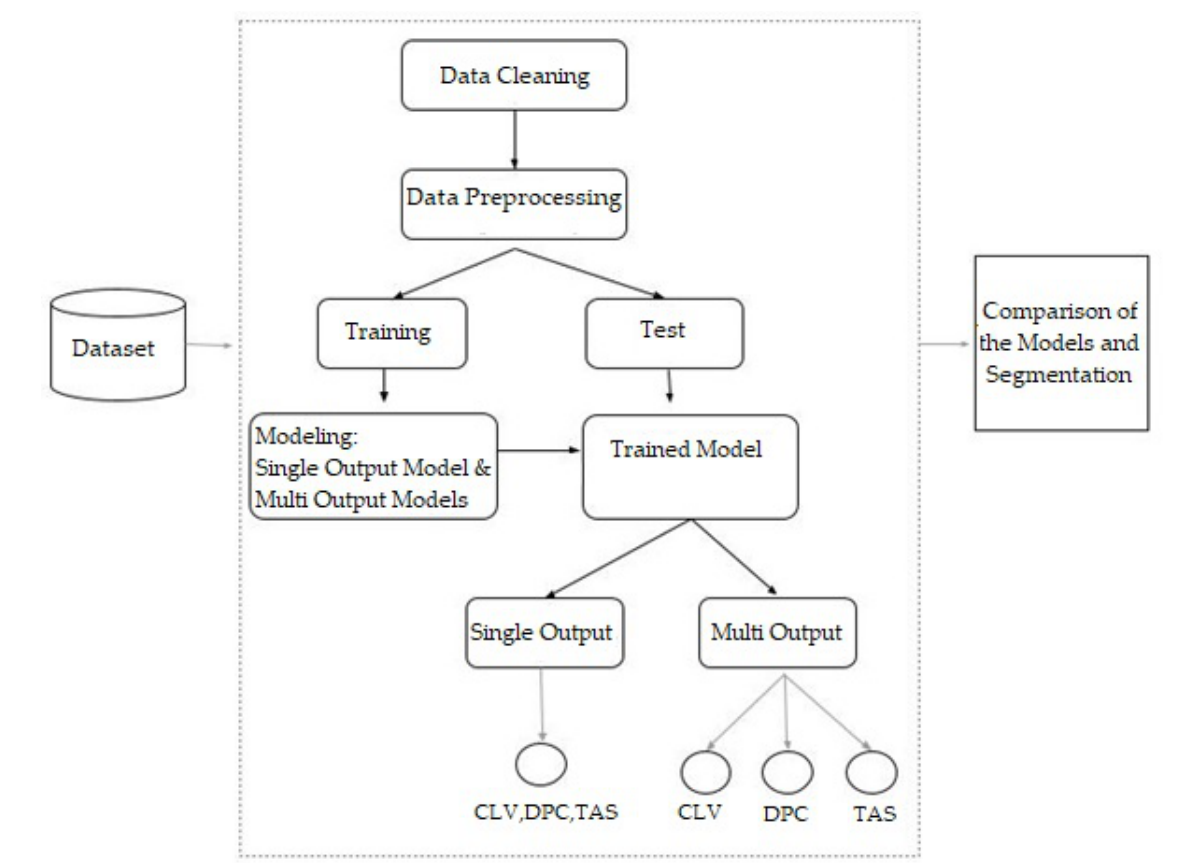
Figure 1. Steps in the proposed process; CLV-customer lifetime value, DPC-distinct product category, TAS-trend of amount spent.